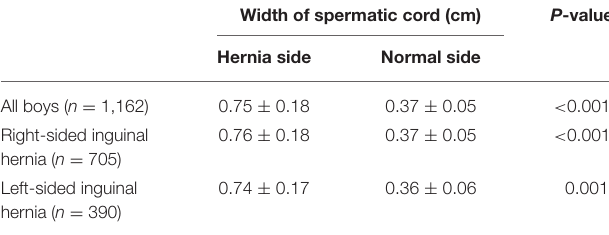
TABLE 1 | The sonographic width of spermatic